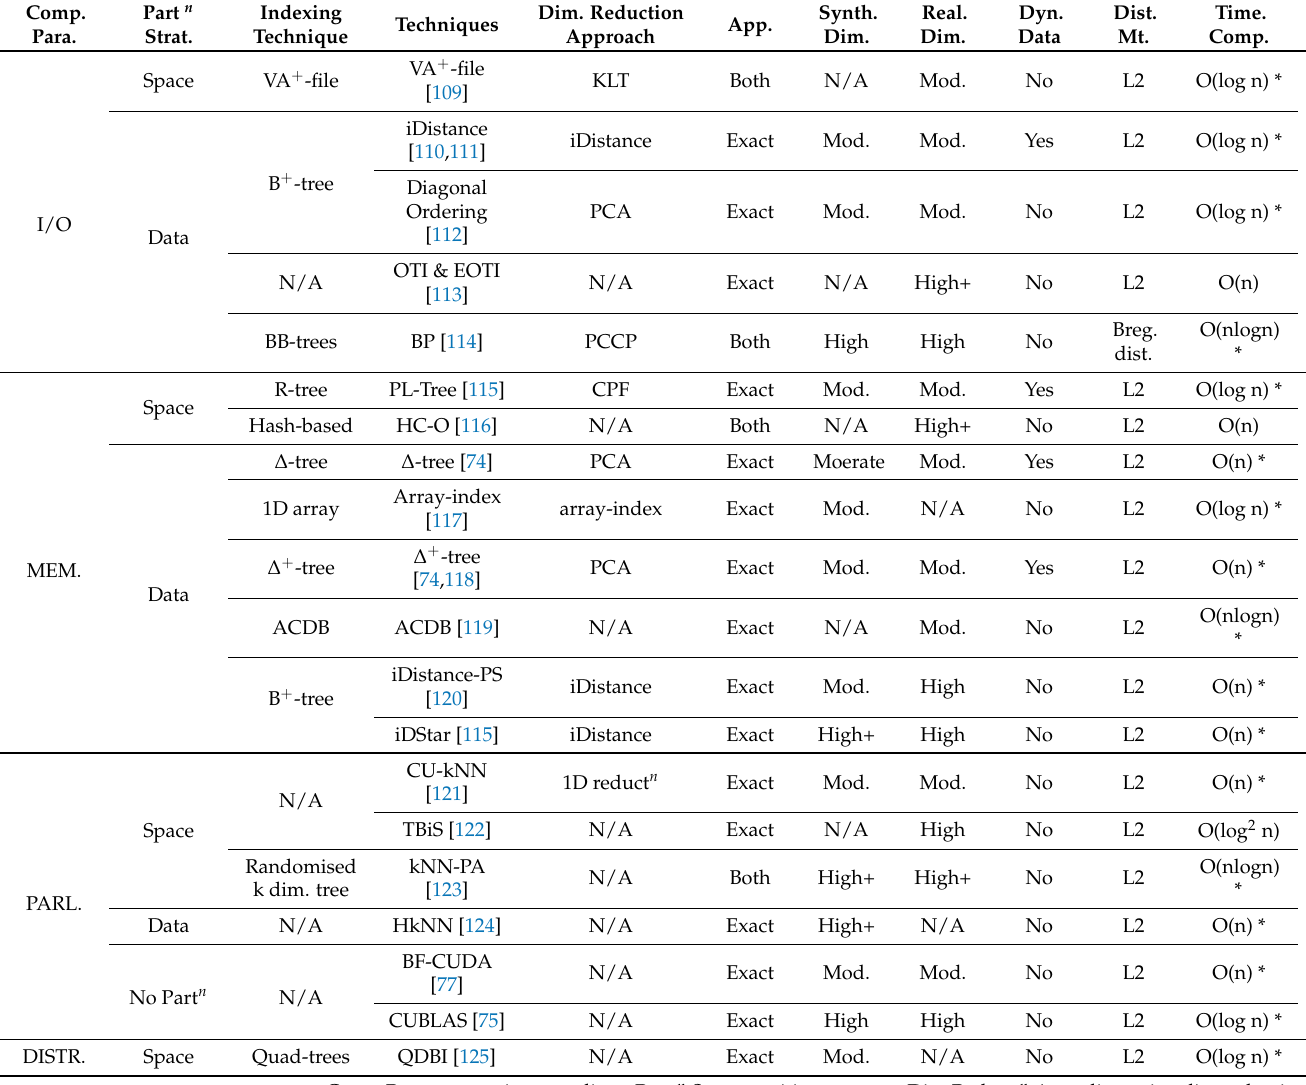
Table 3. Summary of kNN Search